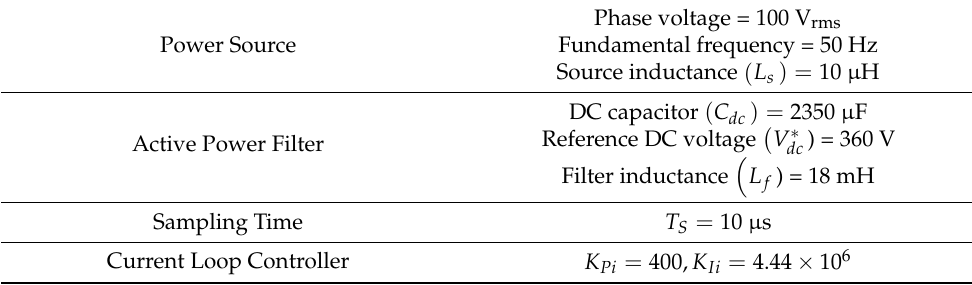
Table 1. The system parameter and the PI controller parameter.